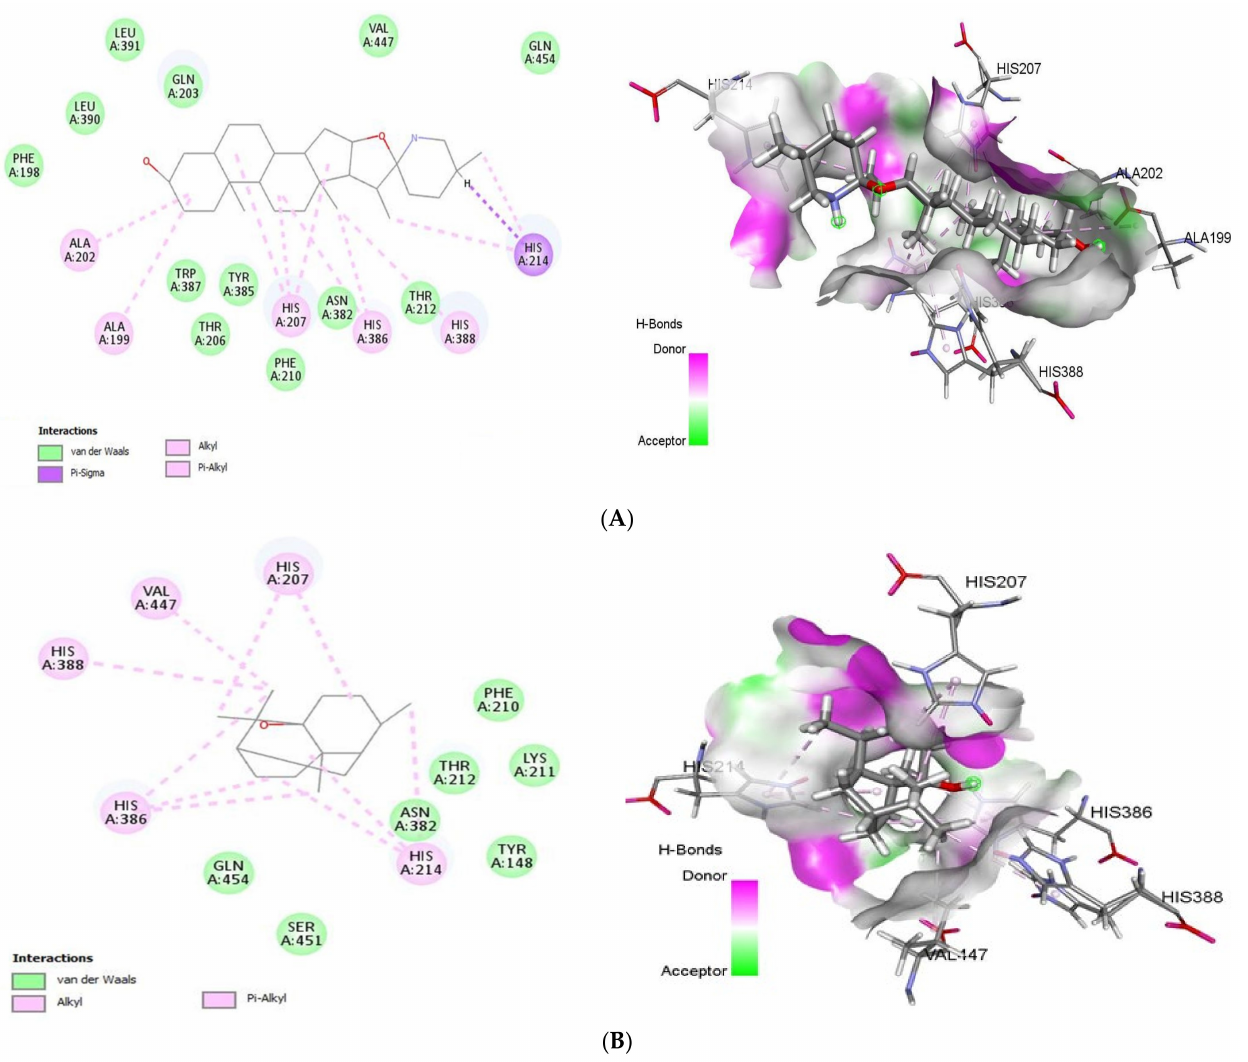
Figure 4. 2D (left) and 3D (right) of tomatidine ( A ) and patchouli alcohol ( B ) with the active site of 5F1A. ( A ): Tomatidine- COX-2 (PDB ID: 5F1A) (Gold Fitness Score 43.64); Type of binding: van der Waals: Leu390, Leu391, Gln203, Val447, Gln454, Thr212, Asn382, Phe210, Tyr385, Thr206, Trp387, Phe198;Pi-Sigma: His214; Pi-Alkyl: His388, His386, His207, Ala199, Ala202, His214. ( B ): Patchouli alcohol-COX-2 (PDB ID: 5F1A) (Gold Fitness Score 27.73); Type of binding: van der Waals: Phe210, Lys2111, Thr212, Asn382, Tyr148, Ser451, Gln454; Alkyl/Pi-Alkyl: His214, His386, His388, Val447,